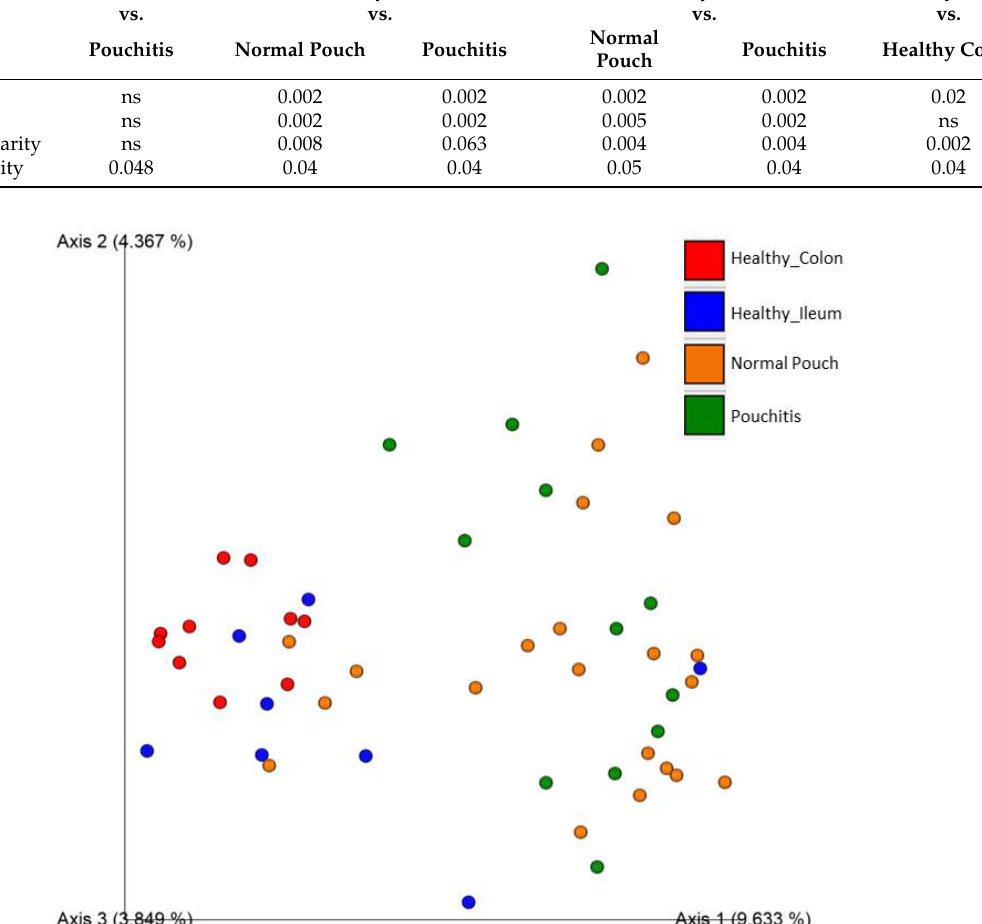
Figure 3. Principal Coordinates Analysis Plot for Healthy Colon (red), Healthy Ileum (blue), Normal Pouch (yellow), and Pouchitis (green) sample groups; distances across samples are calculated through Jaccard Index. More details are in Supplementary File 1.